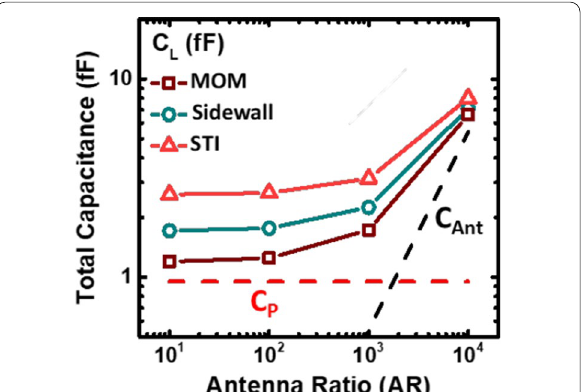
Fig. 7 Comparison of total capacitance versus antenna ratios as the three types of loading capacitors are